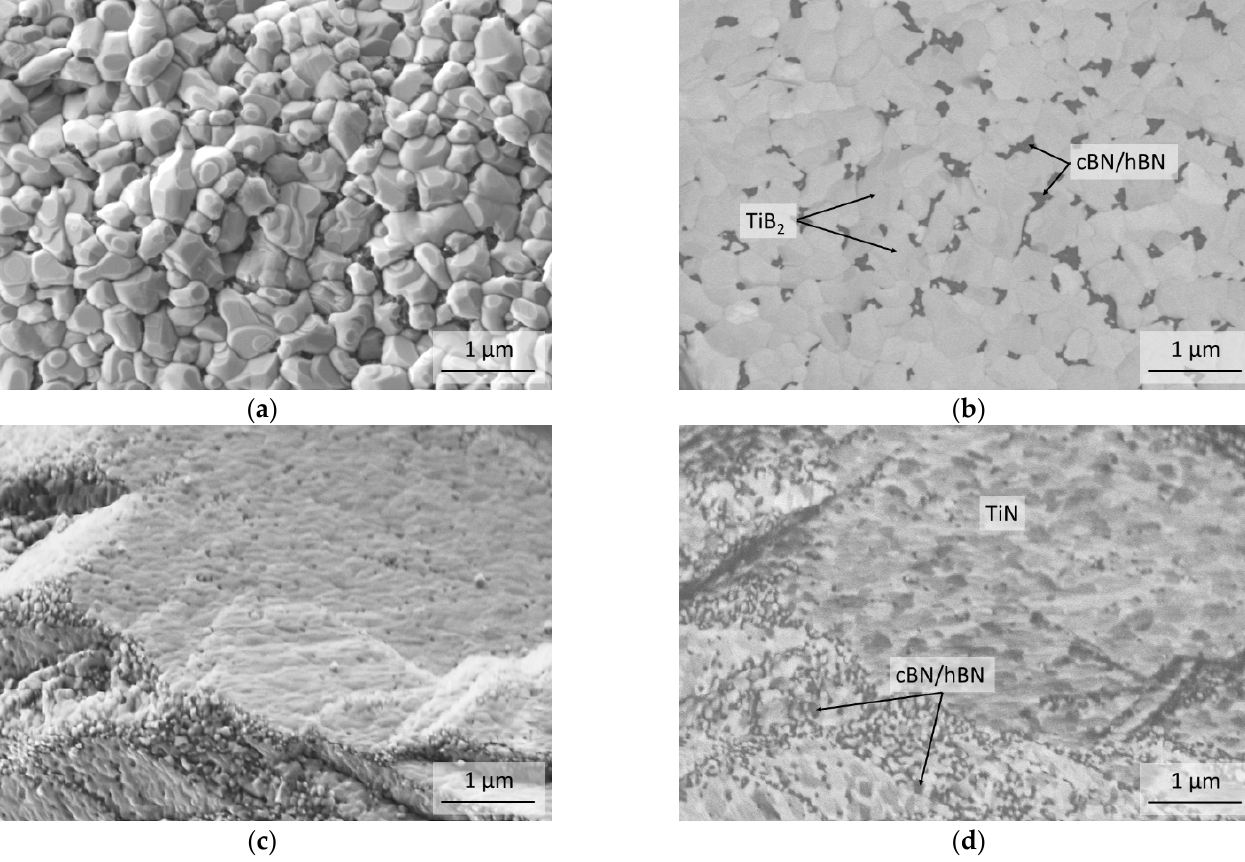
Figure 10. ( a , b ) FESEM micrographs of TiN coated cBN particles heat-treated at 1600 °C under argon and ( c , d ) under nitrogen (a,c with SE2 detector; b,d with ESB detector).